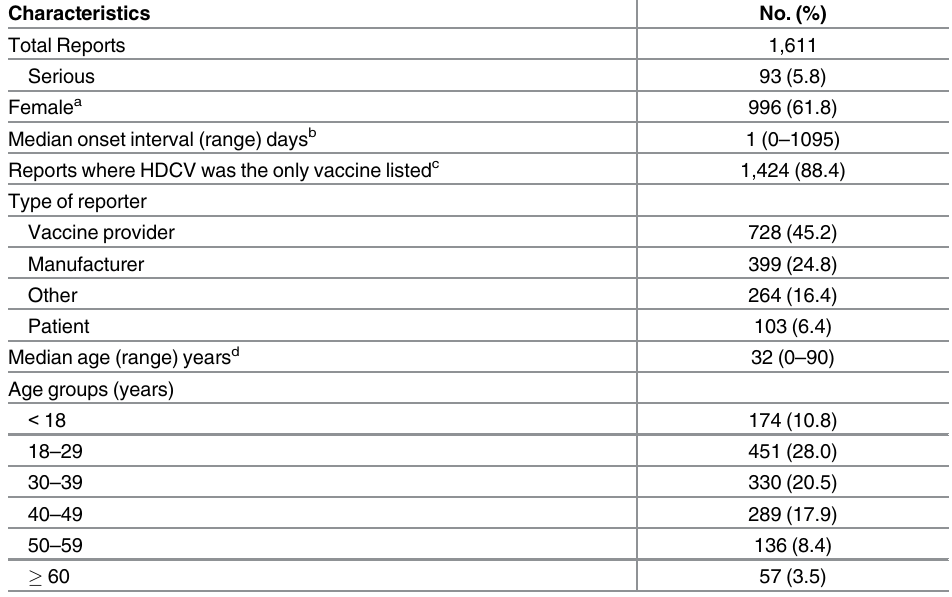
Table 1. Characteristics of human diploid cell vaccine (HDCV, Imovax) rabies vaccine reports to VAERS among persons vaccinated January 1, 1990 through July 31, 2015.